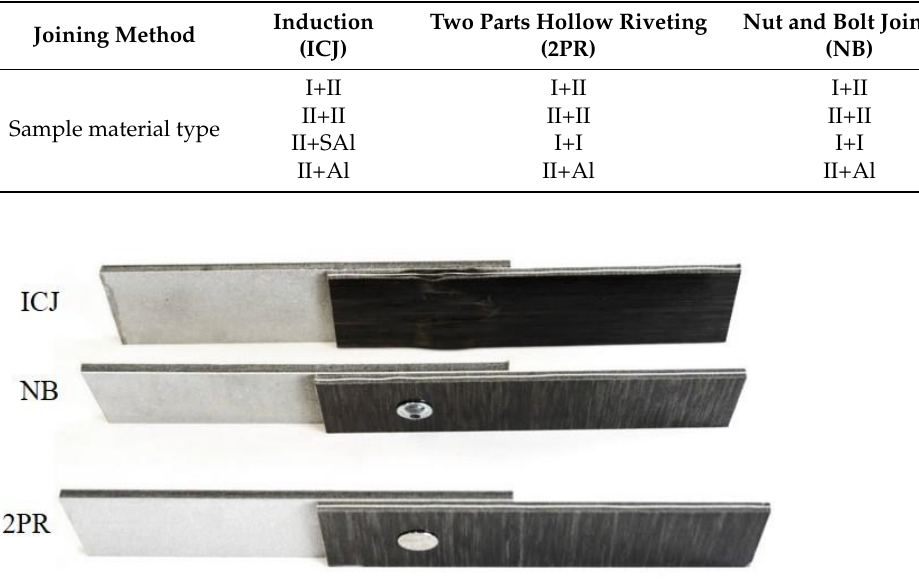
Figure 3. Joining sample dimensions in mm.